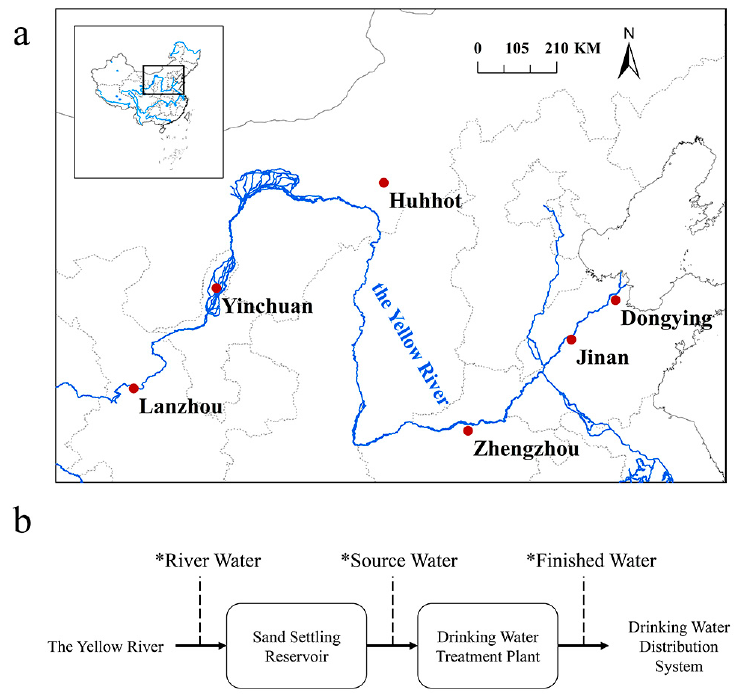
Figure 1. ( a ) Sampling locations (Lanzhou, Yinchuan, Hohhot, Zhengzhou, Jinan, Dongying); ( b ) Drinking water treatment processes, including sand settling reservoir and drinking water treatment. “*”: Sampling sites.